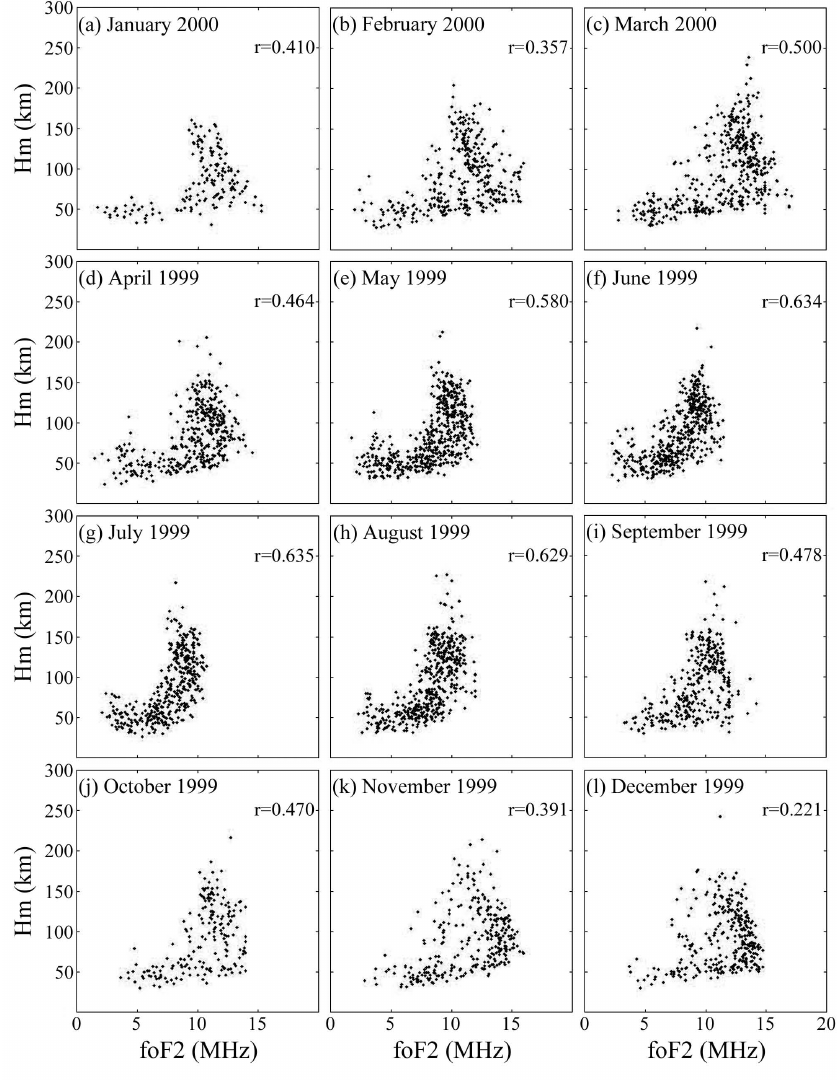
Fig. 5. The scatter plots of Hm versus foF2 during April 1999–March 2000. The correlation coefficient ( r ) of Hm and foF2 is placed in the upper-right